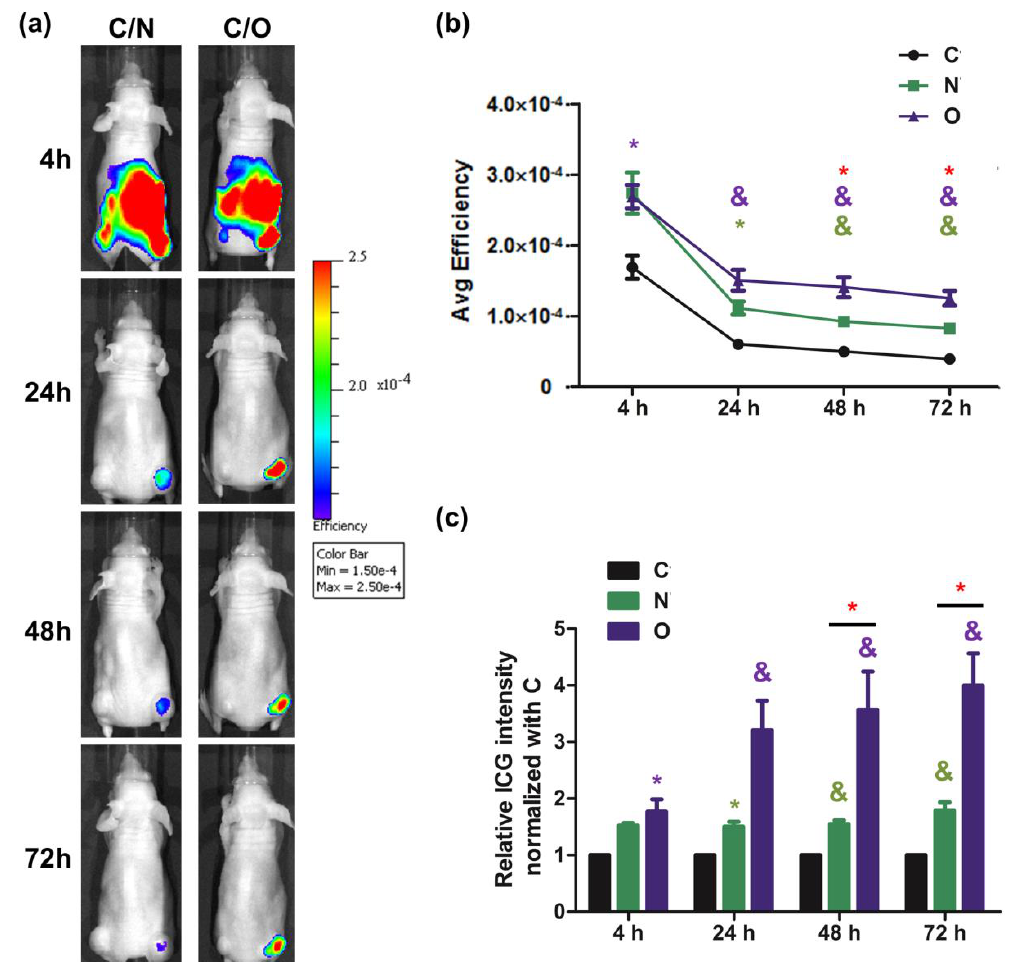
Figure 3. Evaluation of ICG intake in vivo. ( a ) The ICG signal was observed using IVIS at 4, 24, 48, and 72 h after injecting ICG to NTCP - and OATP1B3 -expressing tumor-bearing mice. The tumor on the left hind leg was a controlled tumor, and on the right was an NTCP -expressing tumor at the top and an OATP1B3 -expressing tumor at the bottom. ( b ) The relationship between tumor size and the total efficiency of ICG at 48 h after injecting ICG to NTCP - and OATP1B3 -expressing tumor-bearing mice. ( c ) After the ICG signal was normalized based on control tumor size to obtain relative ICG intensity, we compared the relative ICG intensities in the control and NTCP - and OATP1B3 -expressing tumor cells at 4, 24, 48, and 72 h after injecting ICG into the NTCP - and OATP1B3 -expressing tumor-bearing mice. N = 3 and N = 4 for NTCP and OATP1B3 tumor-bearing mice, respectively. C: control tumor. N: NTCP -expressing tumor. O: OATP1B3 -expressing tumor. Error bars indicate the SEM. * p < 0.05, # p < 0.01, & p < 0.001. *, # , & in purple and green color indicate the control compared with OATP1B3 - and NTCP -expressing tumor cells, respectively. * in red color indicates the NTCP -expressing tumor cells compared with OATP1B3 -expressing tumor cells. Ctrl: control tumor cells.